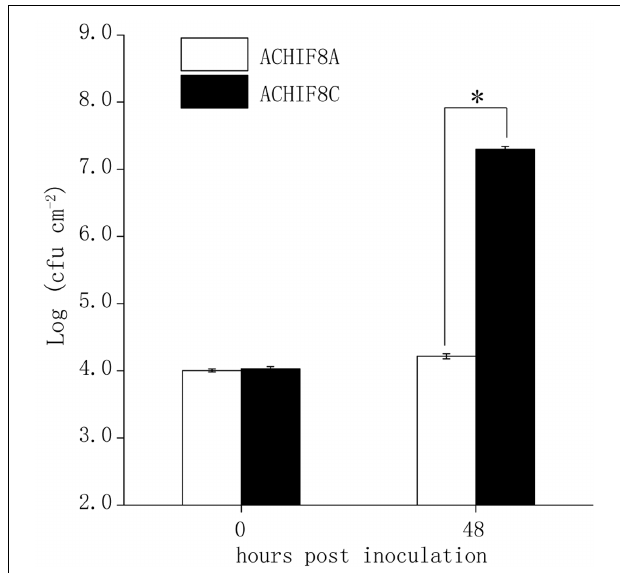
FIGURE 4 | Validation of the major QTL Qpm3.1 in Aa-0 with the heterogeneous inbred family (HIF). Forty-eight individuals of a Col × Aa HIF (ACHIF8) were inoculated with ES4326-lux at OD 600 = 0.003. The inoculated plants were covered to keep high relative humidity. Genotypes of individual plants were determined with the tightly associated marker 1.3 Mb and sizes of the bacterial population were compared between plants with homozygous Aa-0 (ACHIF8A) and plants with homozygous Col-0 (ACHIF8C) genotypes. Data shown are means ± SD ( n = 8). The asterisk indicates a significant difference between treatments (Student’s t -test, P < 0.05). The experiment was repeated three times with similar